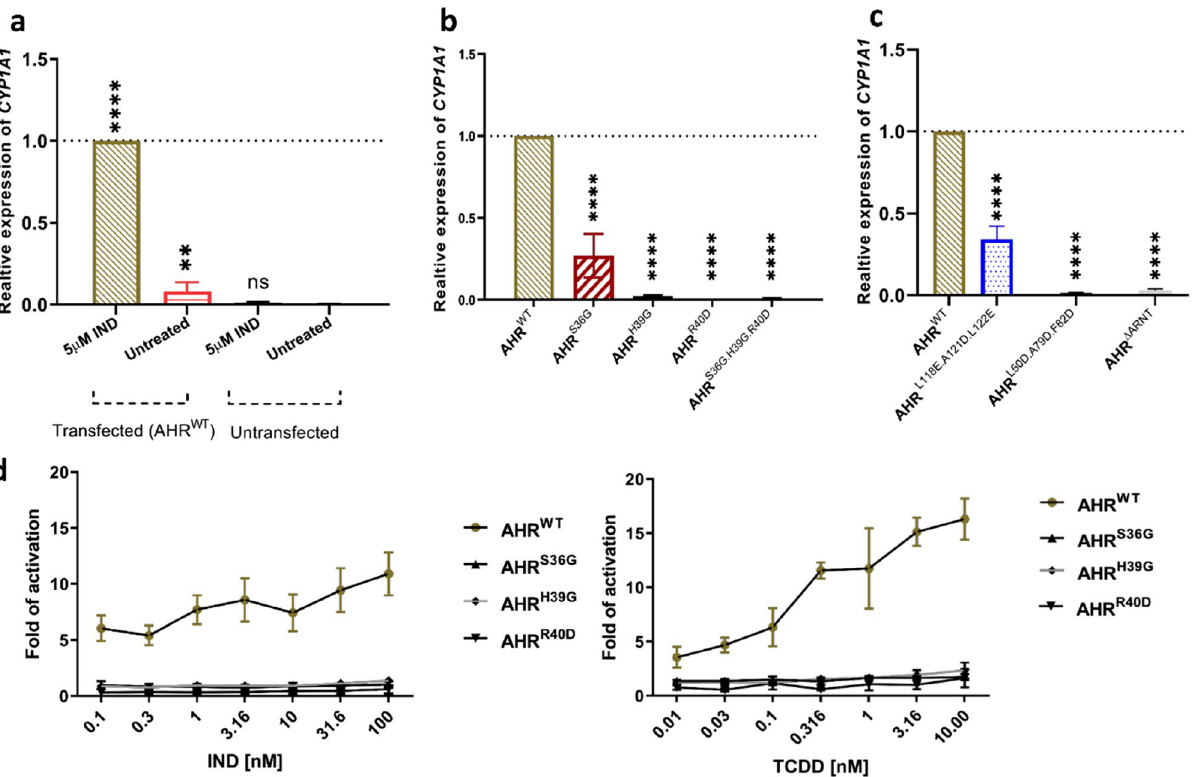
Figure 2. Transcriptional activity of the AHR and AHR mutants. Relative CYP1A1 mRNA level determined by qPCR in MCF-7 ΔAHR cells. Values were standardized against HPRT and normalized against AHR WT transfected cells treated with 5 µM indirubin (IND) for three hours. Depicted are the results for a comparison of treatment and AHR WT transfection ( a ), AHR DNA-binding deficient mutants ( b ) and AHR mutants deficient for ARNT dimerization ( c ). ( d ) Luciferase activity driven by an XRE-promoter after stimulation with increasing concentrations of IND and TCDD for twenty-four hours. ( a – c ) Each bar represents the mean of three biological replicates ± S.D., One way Anova (ns: not significant, ** P < 0.01, **** P < 0.0001). ( d ) Presented are the means of three biological replicates + /-